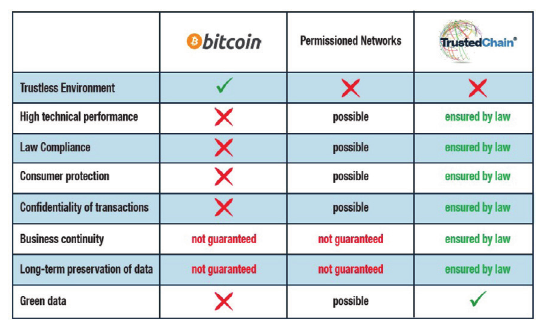
Figure 2: - Basic features of Bitcoin, permissioned networks and